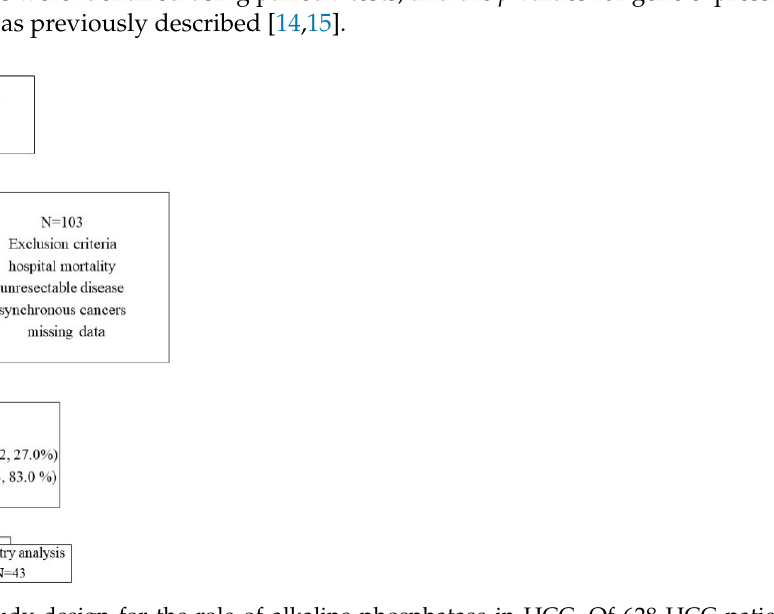
Figure 1. The study design for the role of alkaline phosphatase in HCC. Of 628 HCC patients re- viewed, 525 were eligible for analysis and 43 of them were further analyzed in volumetry analysis.